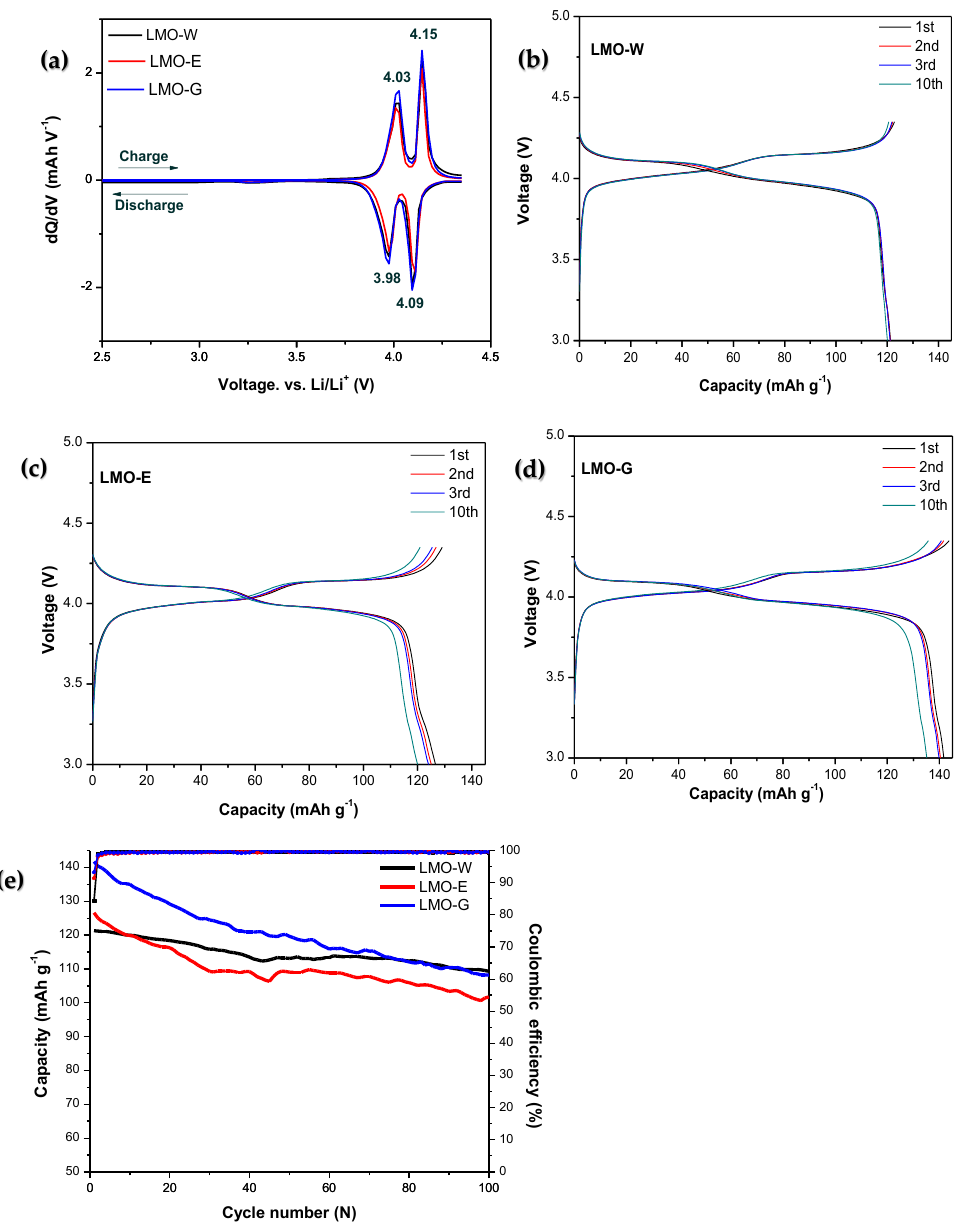
Figure 6. ( a ) dQ/dV plots of LMO-W, LMO-E, and LMO-G powders. Charge/discharge capacity profiles of ( b ) LMO-W, ( c ) LMO-E, and ( d ) LMO-G. ( e ) Discharge cycling performance of LMOs after 100 cycles over a cut-off voltage range of 3.0 V to 4.35 V at 0.5 C.